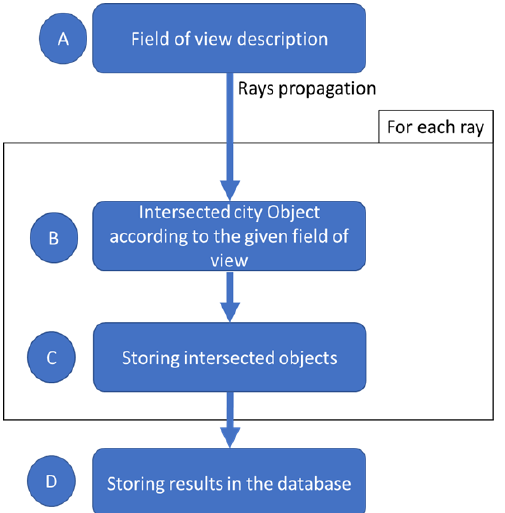
Figure 4. Composition of the 3D view in four steps: Field of View Description (Step A), Intersecting Objects in the 3D Scene (Step B), Storing intersected objects (Step C) and Storing results in the database (Step